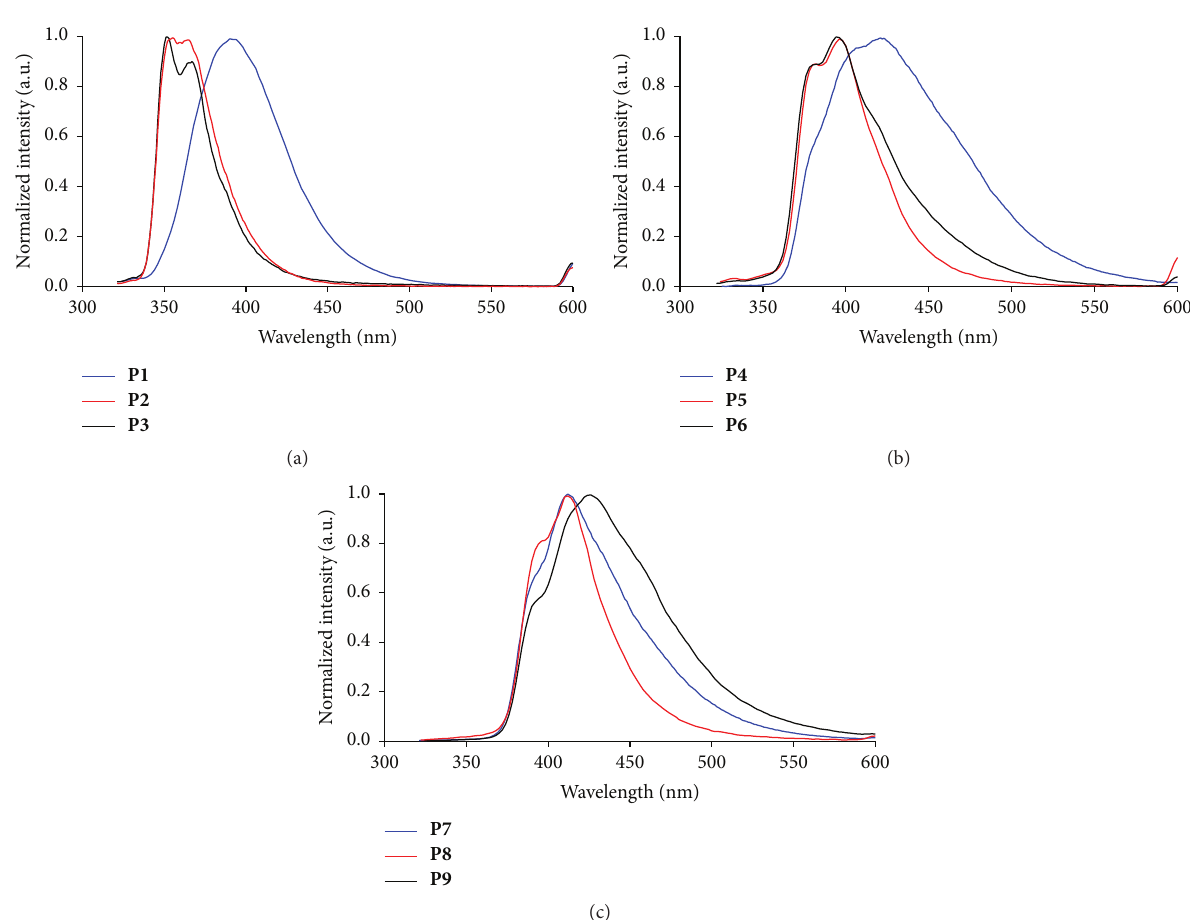
Figure 5: Emission spectra of (a) P1 , P2 , and P3 ; (b) P4 , P5 , and P6; and (c) P7 , P8 , and P9 recorded in DMF at 30 ∘